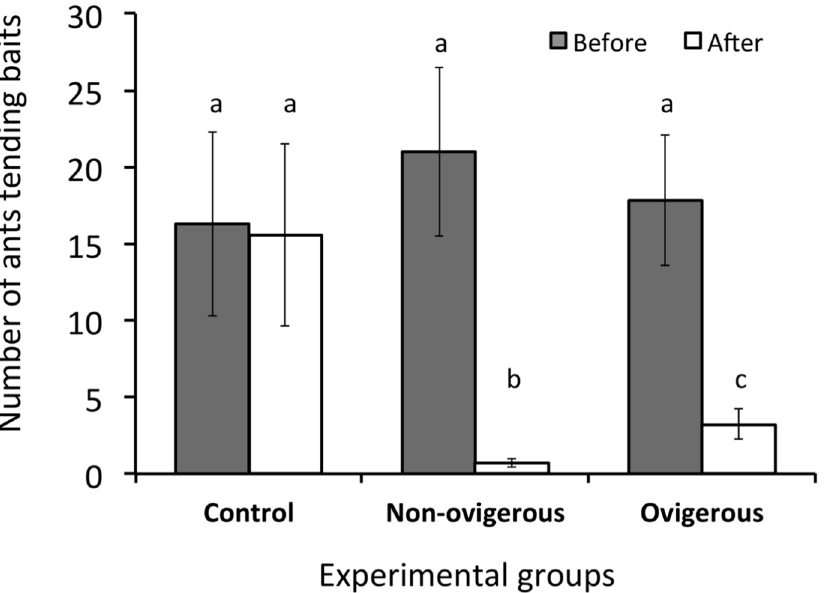
Fig 3. Results of the field experiment in which the number of ants tending sugar baits was counted before and after stimulation with one of the three experimental groups: (1) secretion of one non- ovigerous female of Acutisoma longipes , (2) secretion of one ovigerous female of A . longipes , and (3) distilled water (control). Different letters indicate significant differences (post-hoc test, p < 0.05).